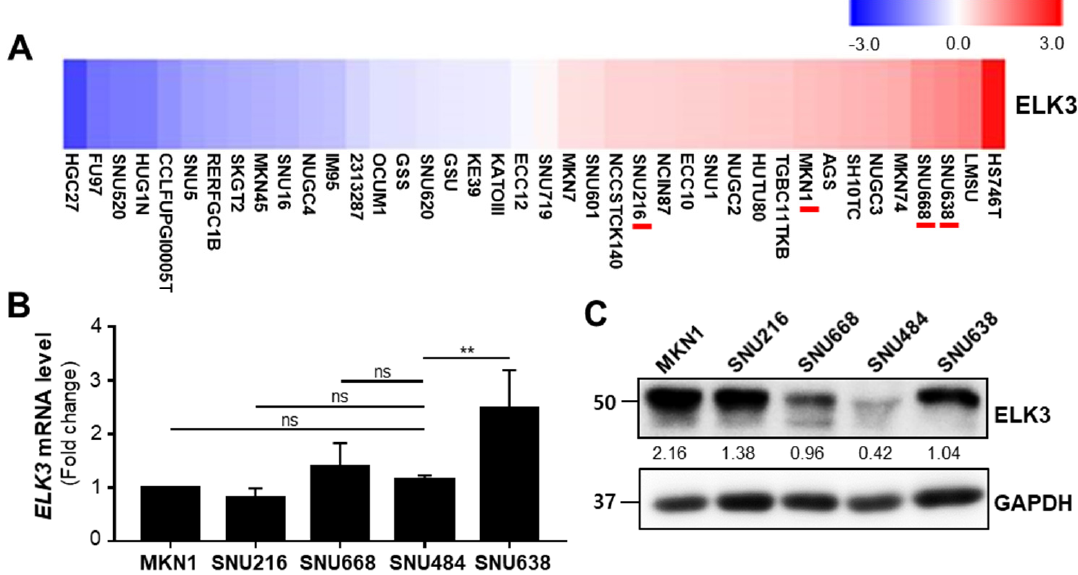
Figure 1. ETS transcription factor ELK3 (ELK3) expression pattern in various gastric cancer cell lines. ( A ) ELK3 expression in gastric cancer cell lines from the Cancer Dependency Map (DepMap) database. ( B ) ELK3 mRNA expression in five gastric cancer cell lines, measured by reverse transcription- quantitative PCR. Error bars represent the standard deviation; ** p < 0.01 (one-way ANOVA). ( C ) ELK3 protein levels in five gastric cancer cell lines. The values indicate the signal intensities of ELK3 relative to GAPDH.